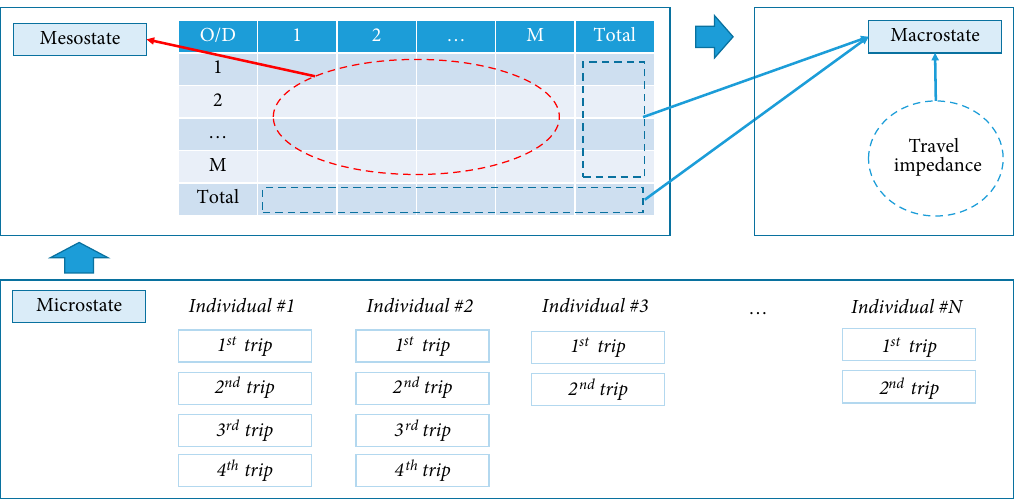
Figure 2: Original system of interest in entropy